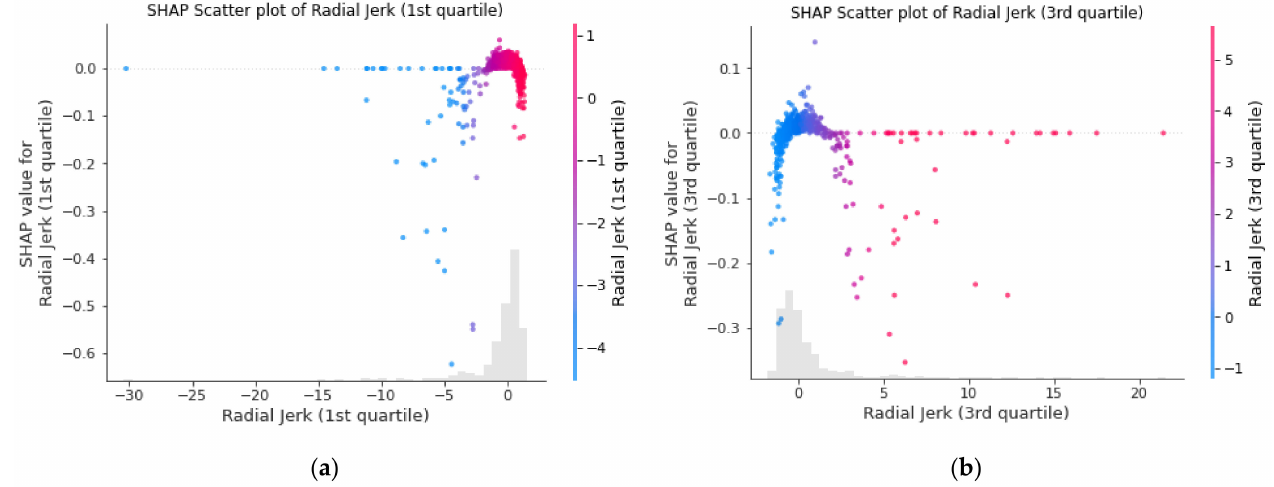
Figure 8. SHAP scatter plot of the ( a ) 1st and ( b ) 3rd quartiles of radial jerk displaying the distribution of contributions of each feature